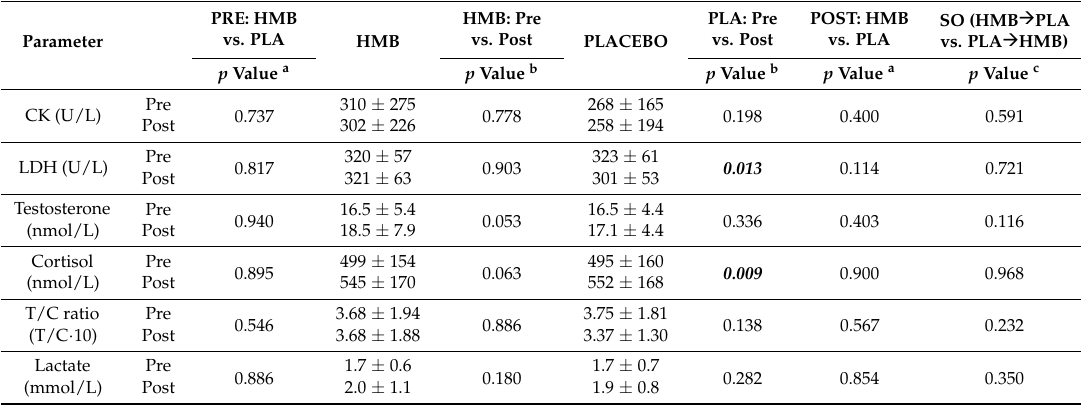
Table 4. Levels of the monitored selected biochemical markers before and after the 12-week supplementation with HMB and placebo